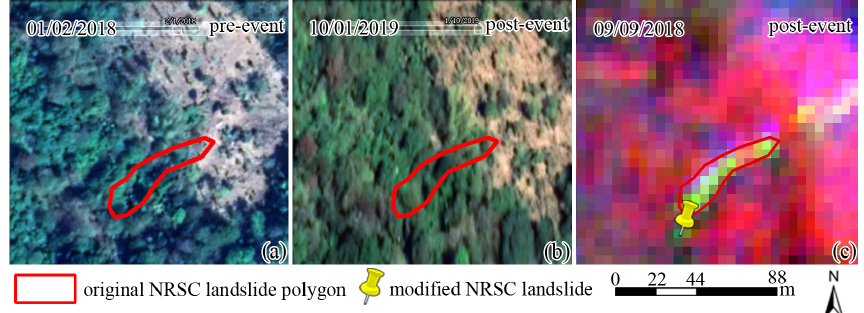
Figure 7. Example of a situation where vegetation regrowth made it difficult to identify the scarps in Google Earth images due to the large time span between the event and the first available images from Google Earth. The original NRSC landslide polygons were generated from the classification of Resourcesat-2 LISS-IV images that were taken within 15 days of the event: (a) pre-landslide Google Earth image, (b) earliest available post-landslide Google Earth image in which the landslide cannot be recognized, and (c) mapping of the landslide initiation point based on Resourcesat-2 LISS-IV images (RGB combination: near infrared, red, green). Basemap data for (a) and (b) © Google Earth